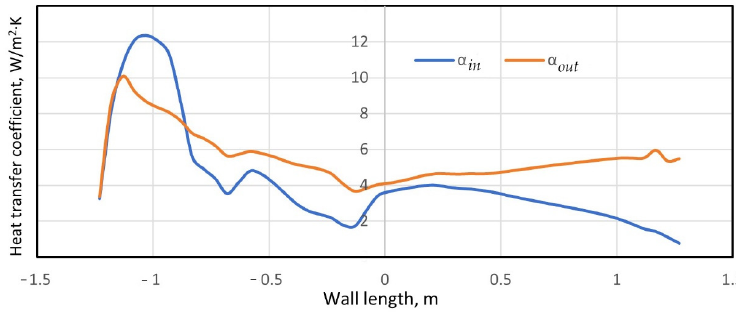
Figure 12. Heat transfer coefficients on the right wall .